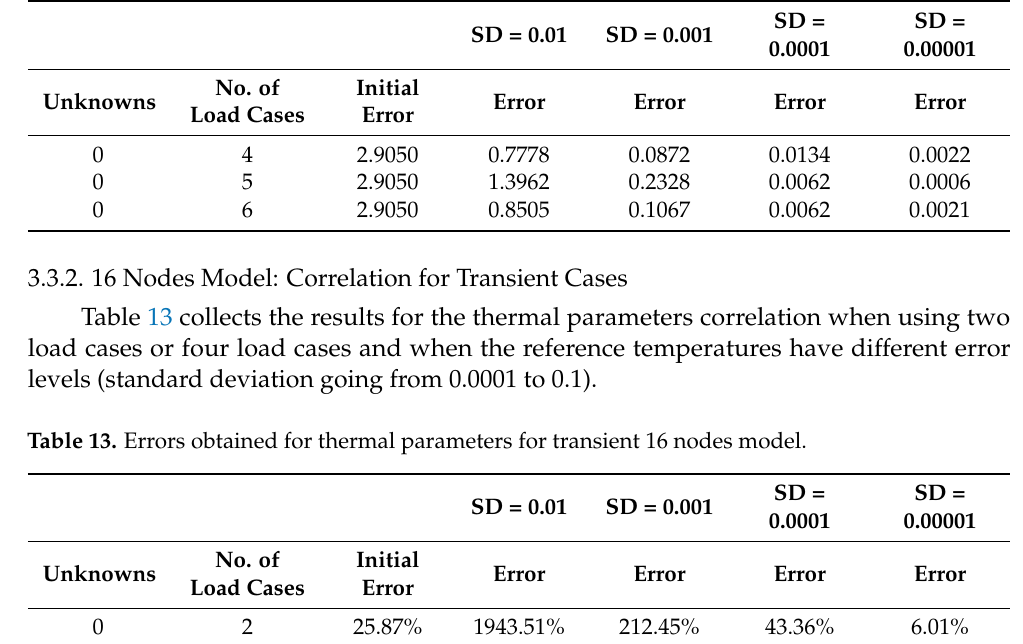
Table 12. Errors obtained for predicted temperatures for steady state 16 nodes model.